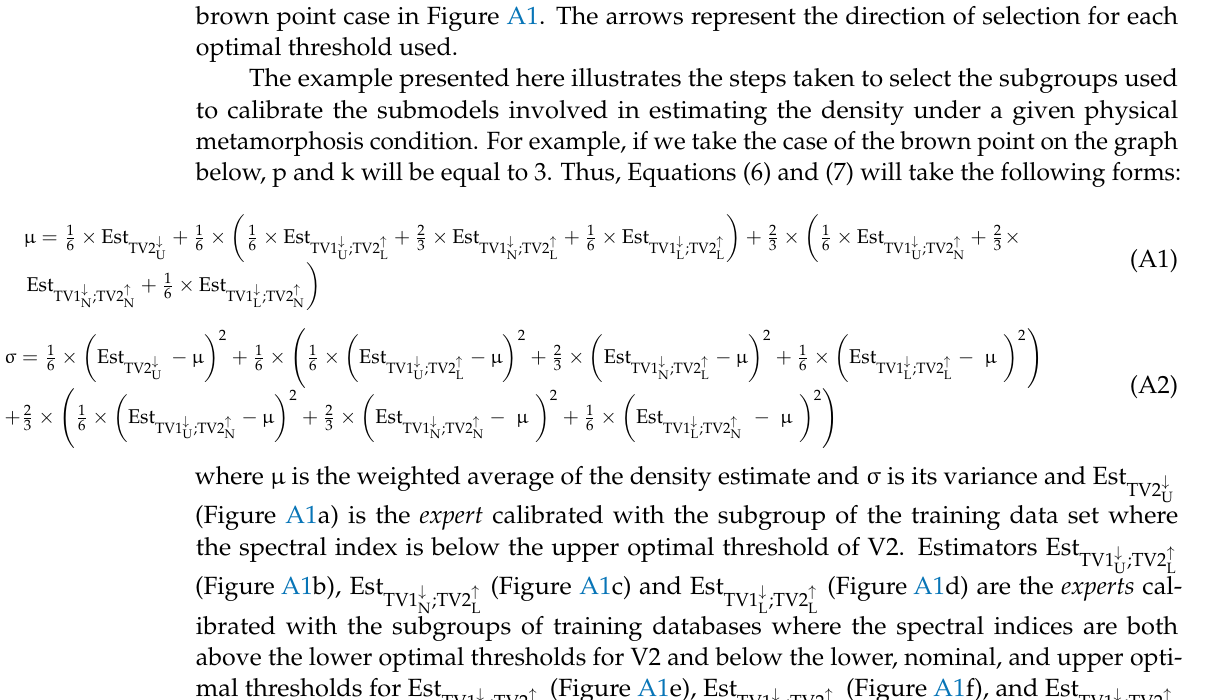
(Figure A1d) are the experts TV1 ↓ L ;TV2 ↑ L